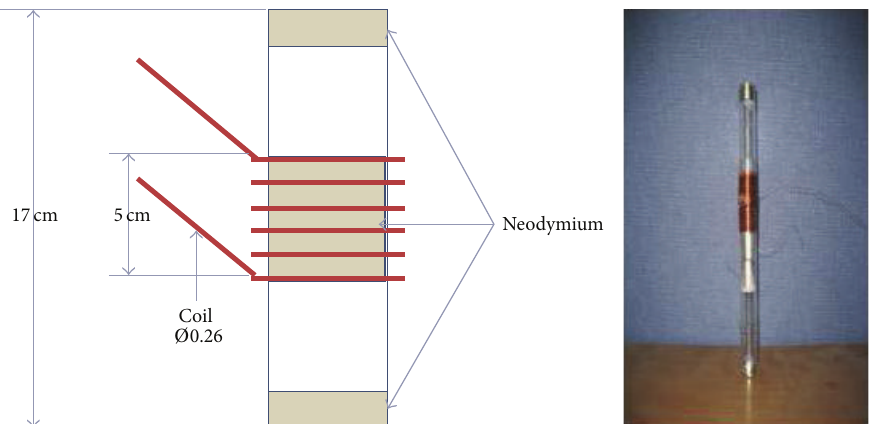
Figure 9: EM-VEH reported in [18] for bridge vibration energy harvesting.